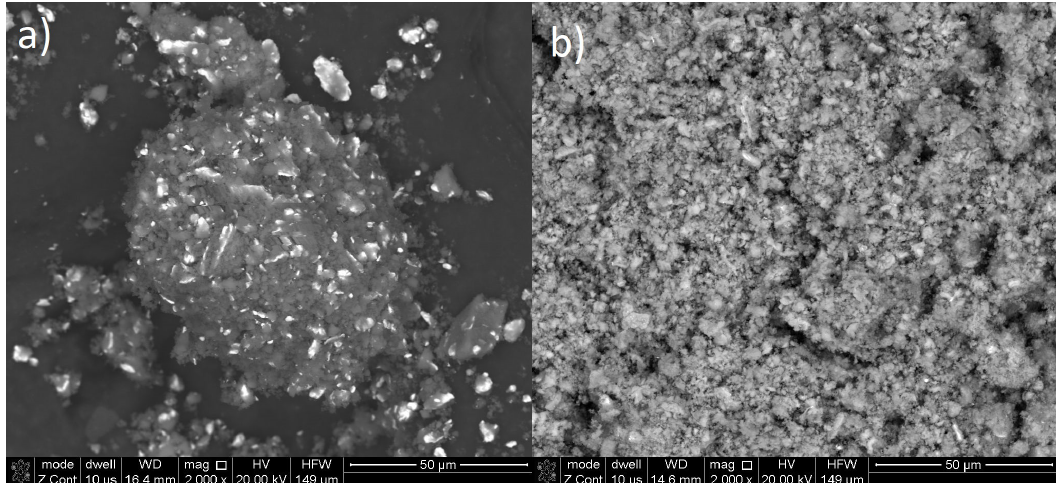
Figure 4. SEM (backscattered electron (BSE) mode) micrographs of exemplary samples ( a ) after 30 min of milling and sintering at 300 ◦ C and ( b ) after 2 h of milling and sintering at 500 ◦